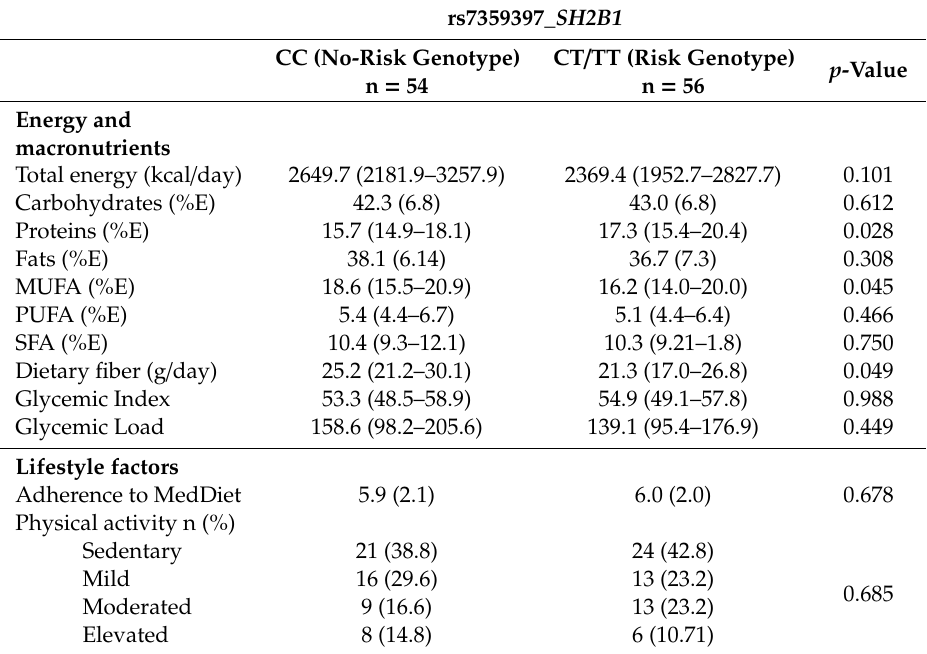
Table 2. Daily nutrient intake and lifestyle factors of participants.